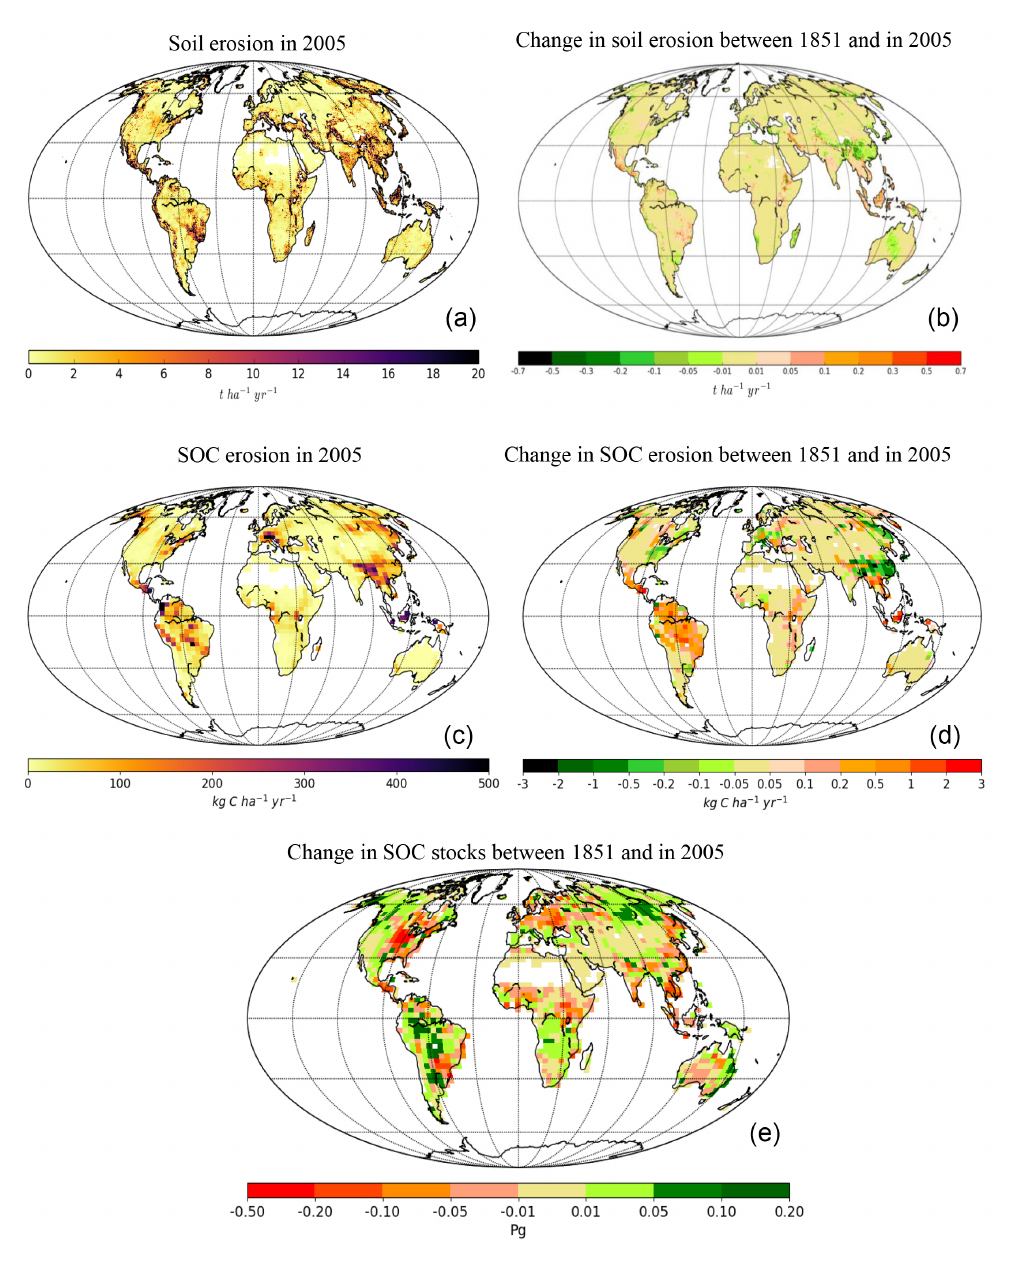
Figure 5. (a) Average annual soil erosion rates at a 5arcmin resolution in the year 2005, (b) change in average annual soil erosion rates over the period 2005–1850, (c) average annual SOC erosion rates at a resolution of 2 . 5 × 3 . 75 ◦ in 2005, (d) change in average annual SOC erosion rates over the period 2005–1850, and (e) difference in SOC stocks at a resolution of 2 . 5 × 3 . 75 ◦ between the year 2005 and 1850 (CTR simulation). For the SOC stocks positive values (green color) indicate a gain, while negative values (red color) indicate a loss. For the erosion rates positive values (red color) indicate an increase over 1850–2005, while negative values (green color) indicate a decrease over